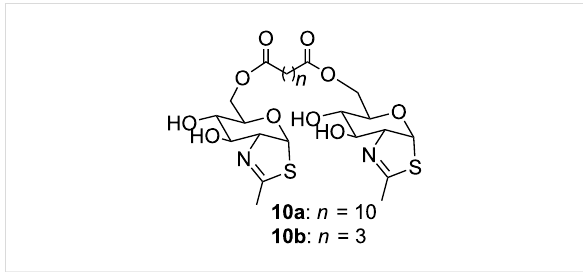
Figure 2: C 6 -dicarboxylic acid diesters derivatives of NAG-thiazoline.